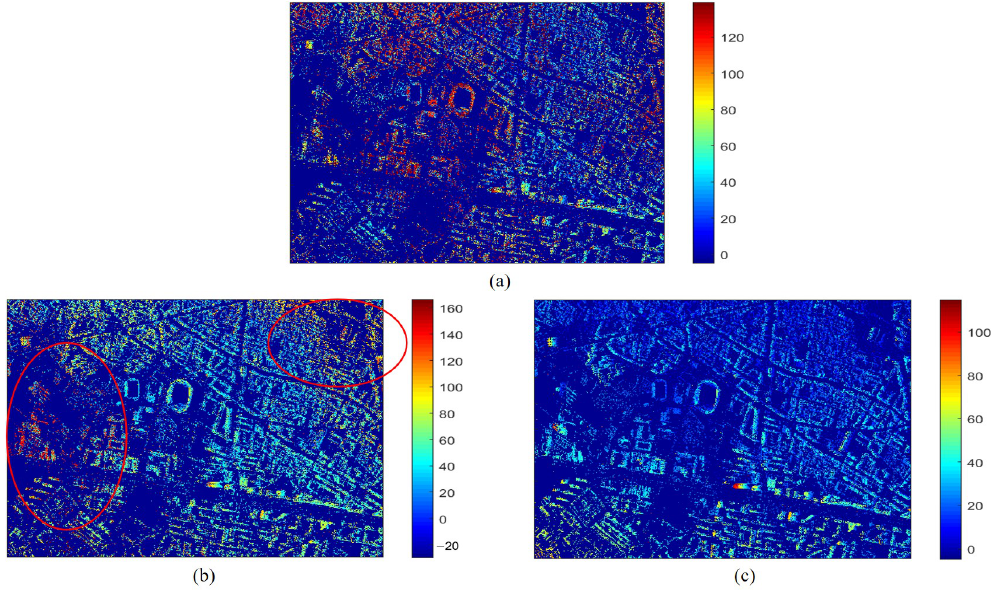
Figure 9. The estimated heights of the study area: ( a ) without PE compensation; with PE compensa- tion using the ( b ) PGA and ( c ) BBN-PGA methods.